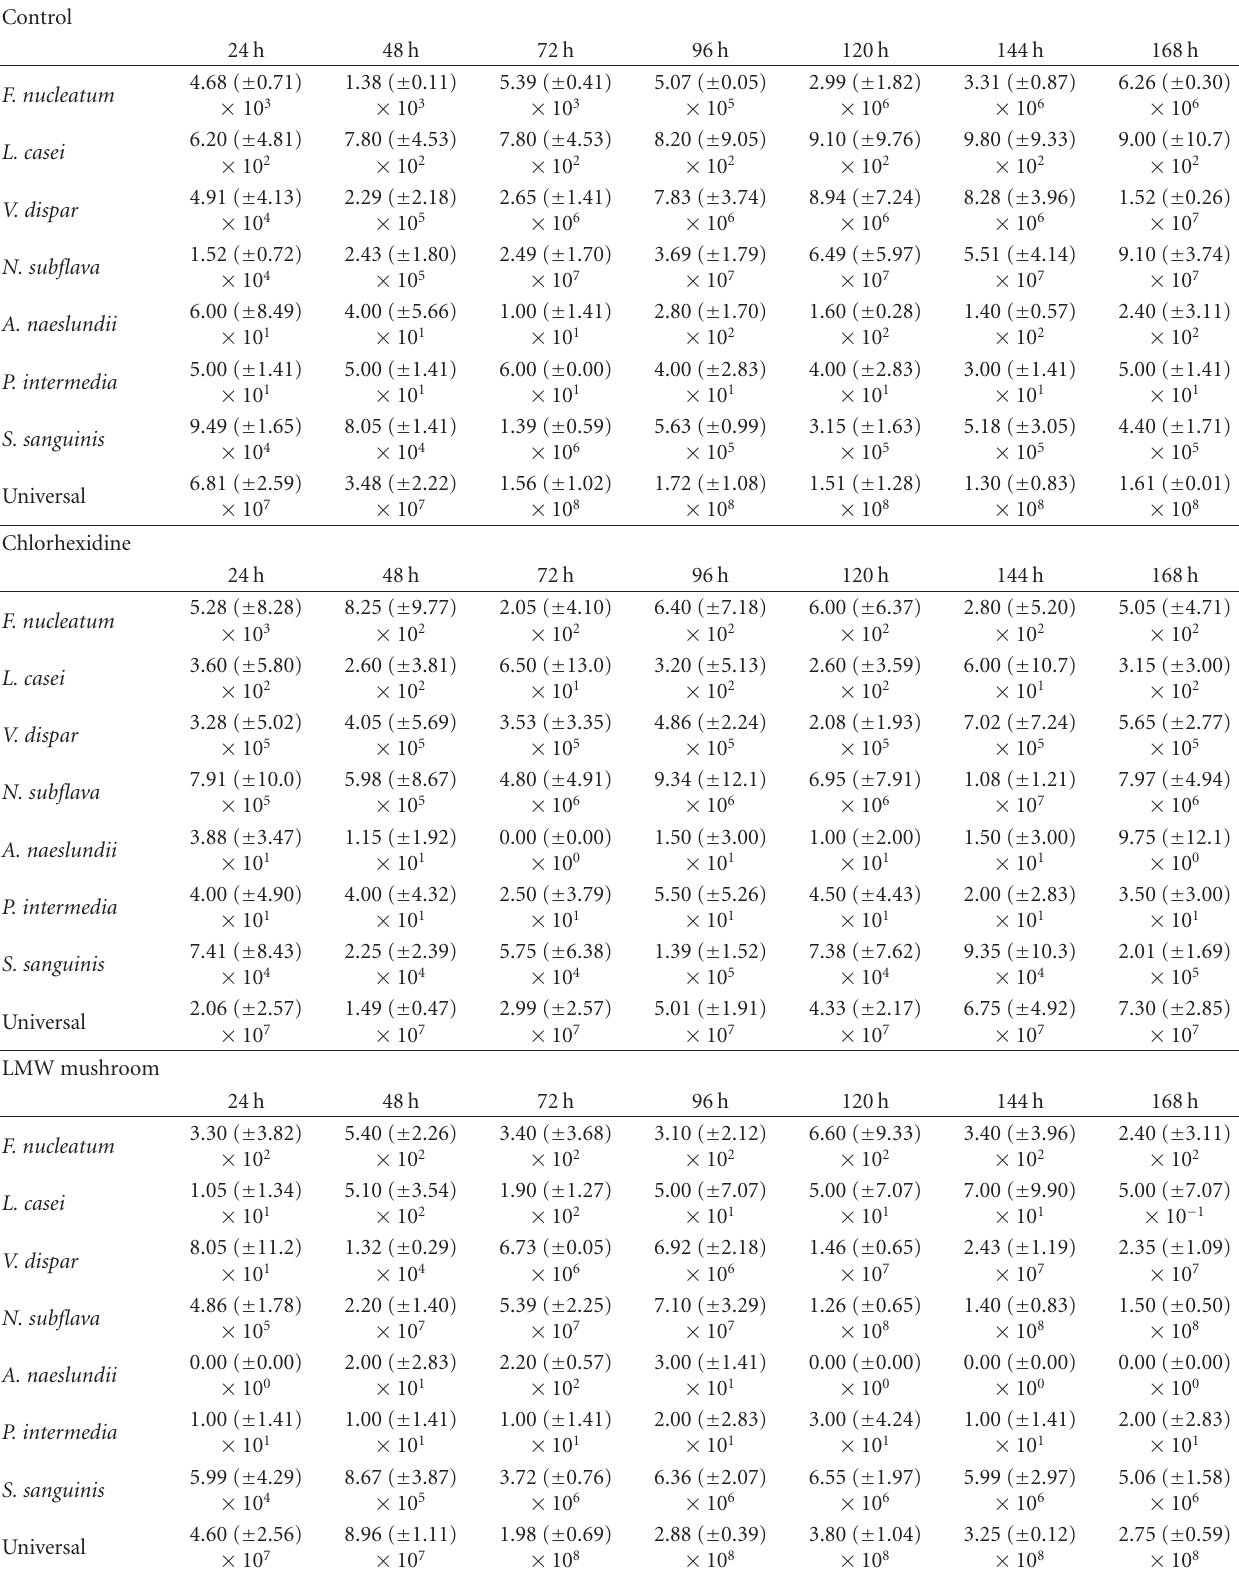
Table 1: Numbers of each of the taxa investigated in biofilms grown in the gingivitis CDFF over one week under various treatments: Control ( n = 2), Chlorhexidine ( n = 4), and LMW mushroom ( n = 2)